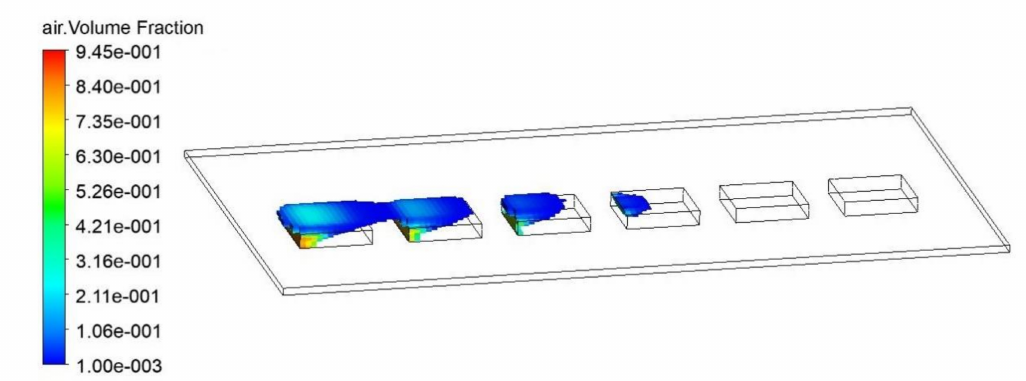
Figure 15. The air volume fraction is generated by a full texturing configuration with dimples side 50 µ m and gap 5 µ m, sliding velocity 5 m / s. Set A of the cavitation coe ffi cients. Only the portions of the mesh where the volume fraction of air is greater than 1% (cid:24) are